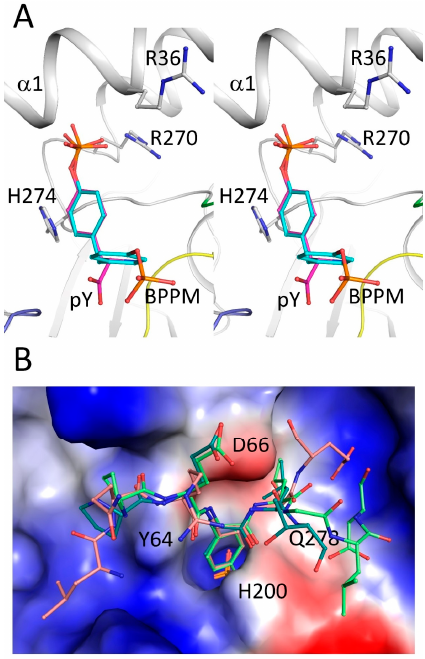
Figure 4. Substrate binding sites of PTPN12. ( A ) A stereoview showing the second substrate-binding site with a docked bis-( para -phosphophenyl) methane (BPPM) molecule ( cyan ) and phosphoryl-tyrosine ( magenta ). The coloring of PTPN12 is the same as that used in Figure 1; ( B ) electrostatic potential surface of the PTPN12 substrate-binding site with superimposed, phosphorylated HER2 peptides (side chains shown). The backbones of the HER2 pY1248, pY1196, and pY1112 peptides are shown in green, dark green, and pink, respectively. Important residues in PTPN12 are labeled on the electrostatic potential surface. Figures were prepared using PyMOL (DeLano Scientific LLC, South San Francisco, CA, USA).